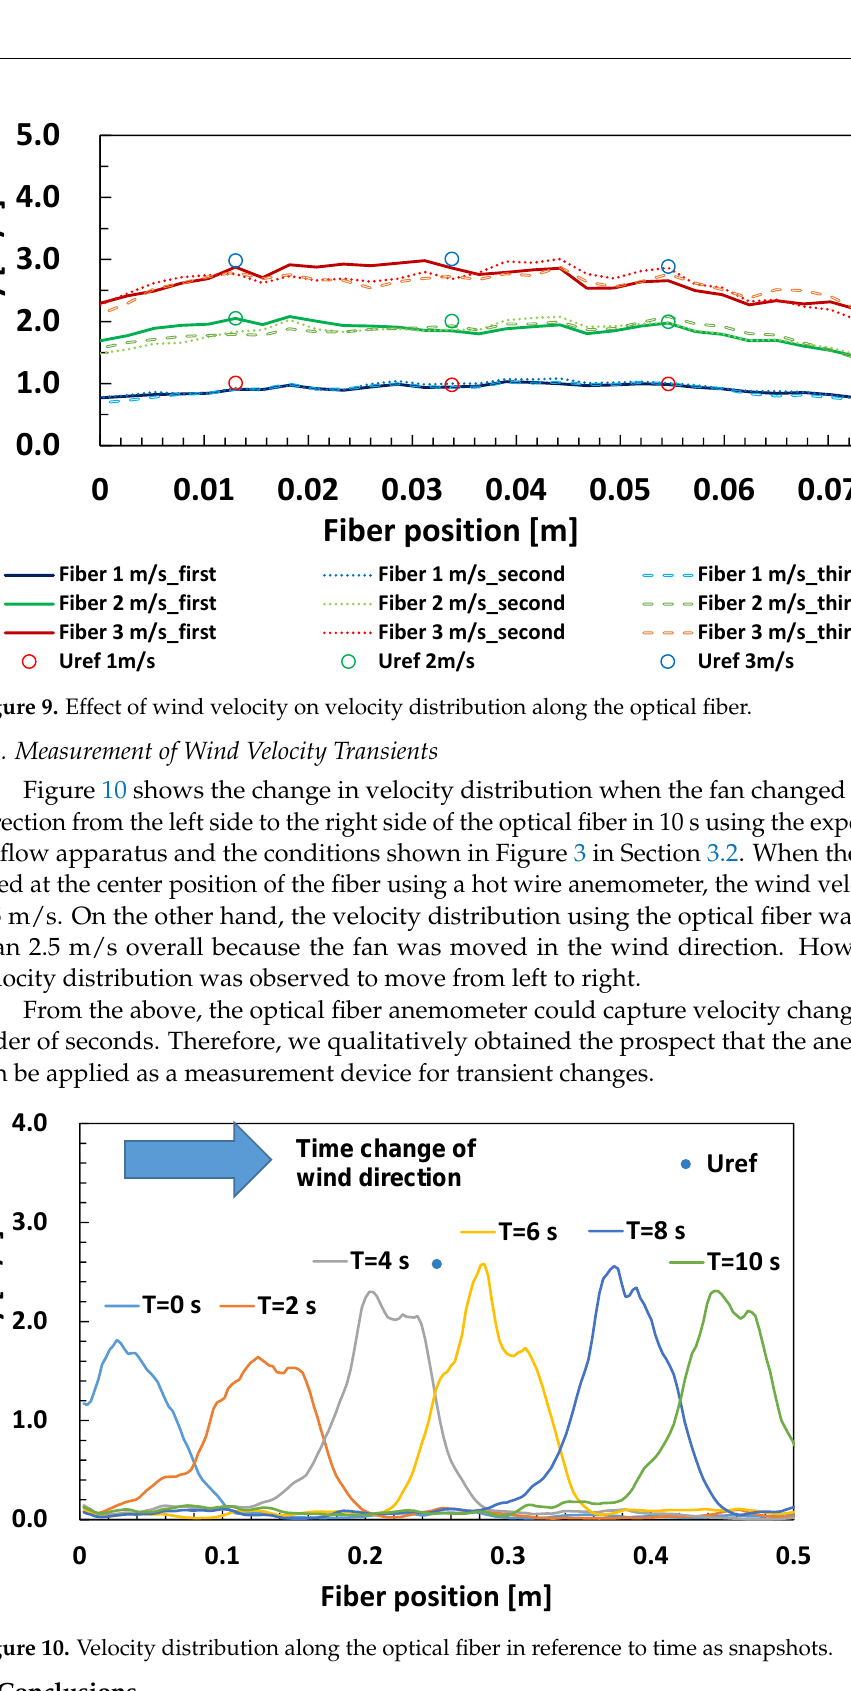
Figure 10. Velocity distribution along the optical fiber in reference to time as snapshots .